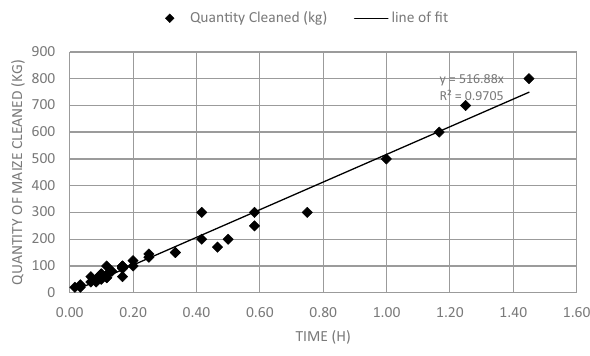
Fig. 4 Quantities of maize cleaned with respect to time taken by different